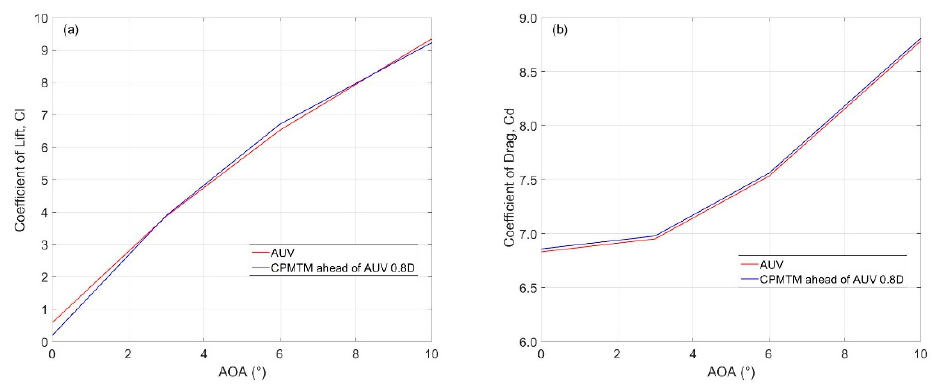
Figure 7. Lift ( a ) and drag force ( b ) coefficient over the angle of attack of the AUV before and after integrating CPMTM.